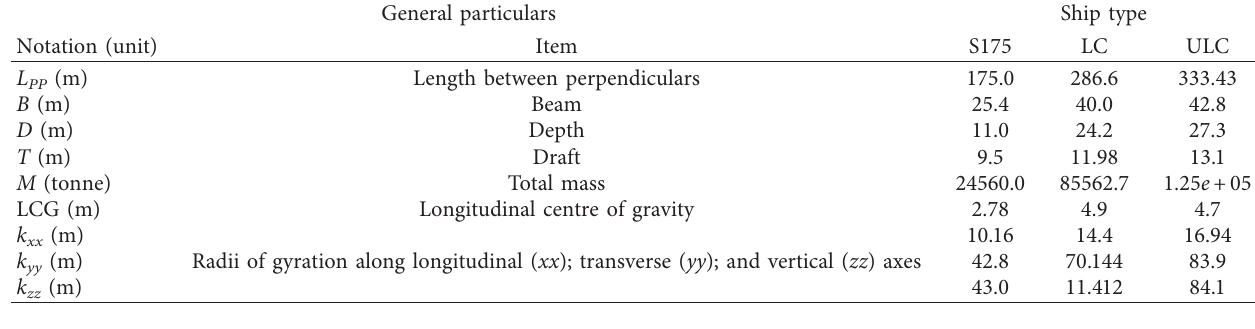
Table 1: General particulars of different container ship models.